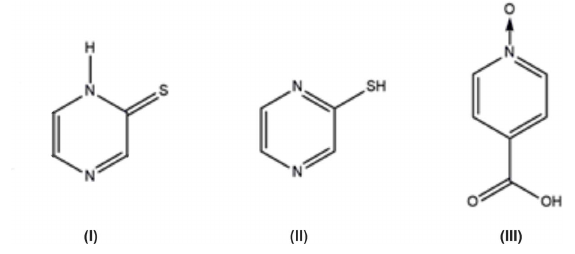
Figure 3 N–H (cid:2)(cid:2)(cid:2) N and C—H (cid:2)(cid:2)(cid:2) S hydrogen bonds between adjacent pyrazine- 2(1 H )-thione molecules.